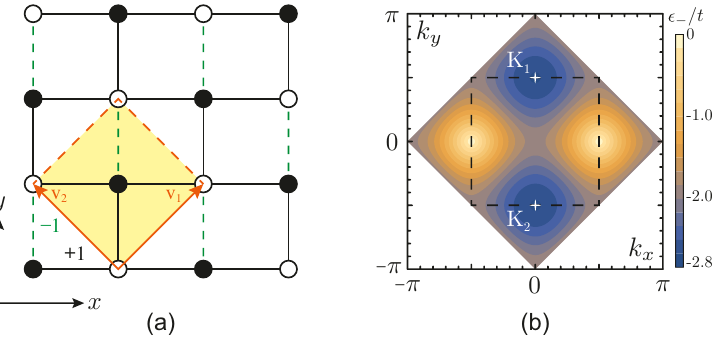
Figure 1 . (a) The Z 2 gauge used in the main text with the real and spin-independent hopping − te iA ij = ± t , which leads to two sites per unit cell. The frustrated bond with e iA ij = − 1 is denoted by a dashed line. (b) In the Z 2 gauge, there are two (doubly) degenerate minima at the two momentum K 1 = (0 , π/ 2) and K 2 = (0 , − π/ 2) . The diamond shape is the Brillouin zone (BZ). The inner dashed line is 1/2 of the BZ. The full square is twice the BZ